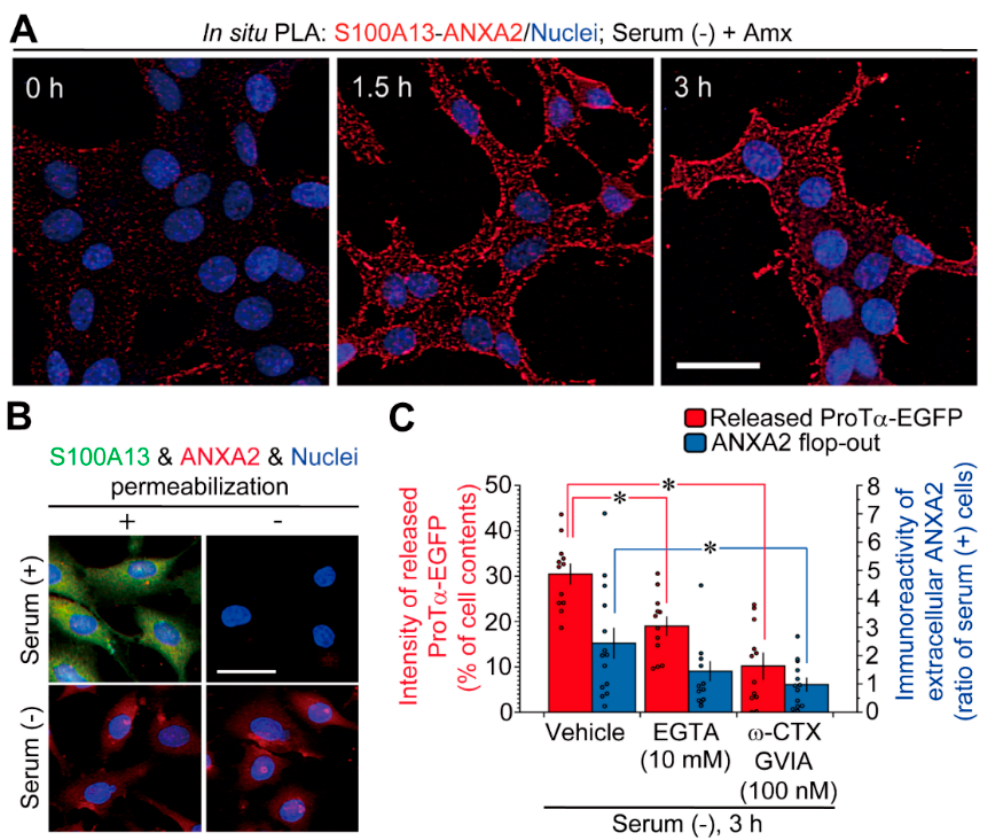
Figure 2. Roles of annexin A2 flop-out in non-classical release of S100A13 and ProT α under serum-free conditions. ( A ) In situ proximity ligation assay (PLA) shows the evidence for stress-induced interaction between S100A13 and annexin A2 (ANXA2) in the presence of amlexanox (Amx). ( B ) ANXA2 flop-out on the cell surface and S100A13 extracellular release under serum-free conditions. Immunocytochemistry was performed using C6 glioma cells with and without permeabilization. Immunocytochemical analyses with and without permeabilization show the presence of immunoreactive (ir)ANXA2, but not irS100A13 in C6 glioma cells following serum-free stress. ( C ) Involvement of the N-type Ca 2+